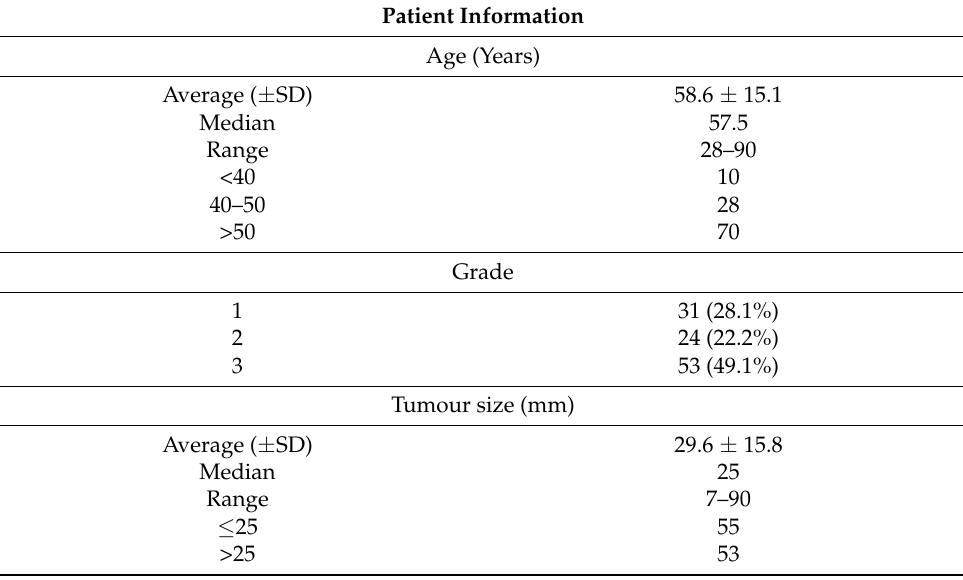
Table 1. Demographic data from 108 breast cancer cases used in this